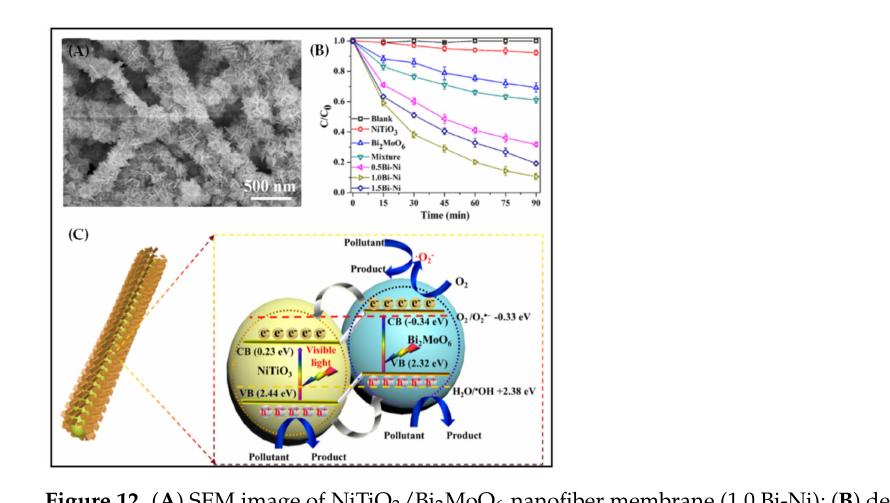
Figure 12. ( A ) SEM image of NiTiO 3 /Bi 2 MoO 6 nanofiber membrane (1.0 Bi-Ni); ( B ) degradation effi- ciency of TC and ( C ) possible photocatalytic mechanism for TC degradation over NiTiO 3 /Bi 2 MoO 6 nanofiber membrane (1.0 Bi-Ni)